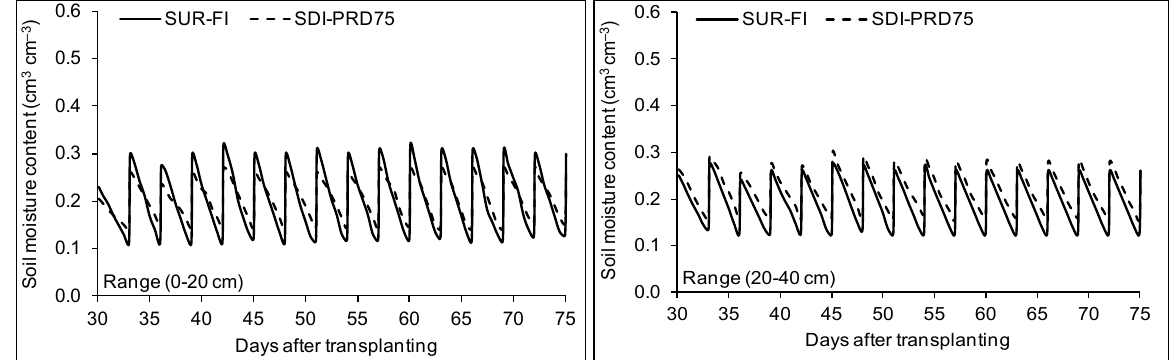
Fig. 2: Temporal changes of moisture content in two different soil layers during the developmental stage for SUR with FI and SDI with PRD 75 (pooled data of the two years). FI = full irrigation; PRD = partial root zone drying; SDI = subsurface drip irrigation; SUR = surface drip